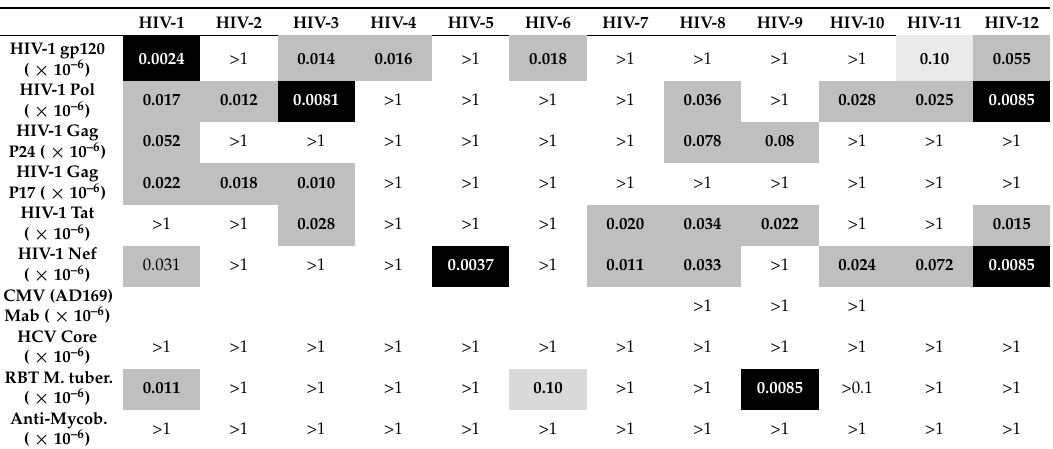
Table 6. Results of quantitative ELISA experiments (see Figures 4 and 5 for examples of data) between HIV-antibodies and TCR from HIV-infected patients (see Table 3).